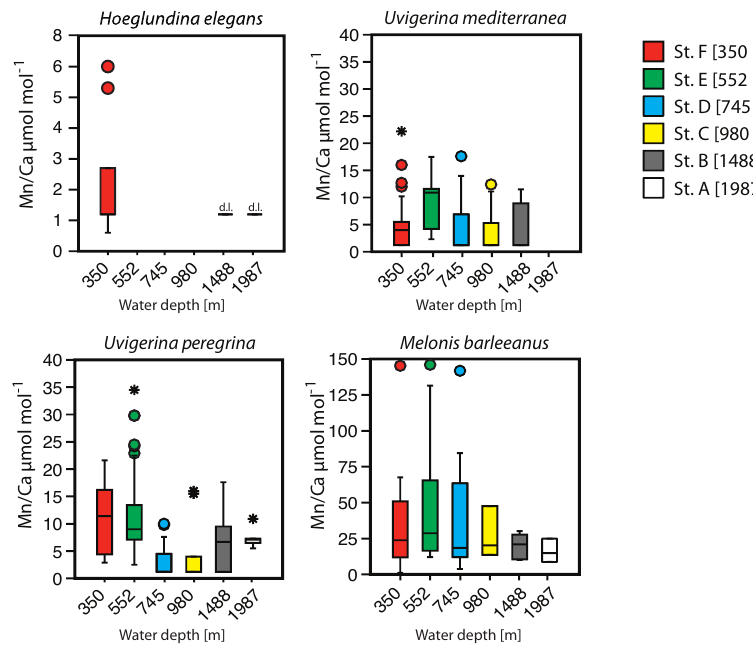
Figure 6. Box plots describing the distribution of Mn / Ca values across a depth transect (350–1987m) measured in living (stained) indi- viduals of Hoeglundina elegans , Uvigerina mediterranea , Uvigerina peregrina , and Melonis barleeanus . Note that the scale of the y axis varies. The box represents all values between the 25th and 75th percentile with the whiskers extending less than 1.5 times the box height. The dissection line through the box denotes the median. Values outside the whiskers are shown as circles, and values further than 3 times the box height are denoted as stars. Detection limit (DL) for H. elegans is indicated when specimens have been measured but the signal was too low.